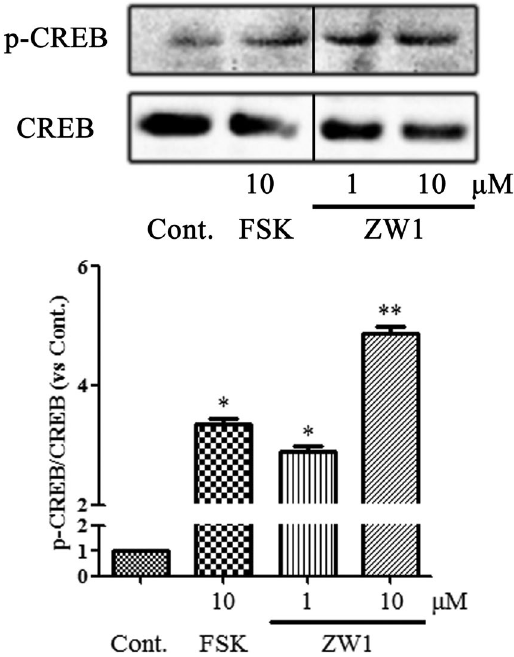
Figure 6. ZW1 promotes phosphorylation of CREB in KGN cells. KGN cells were treated with the test compounds at the indicated concentrations for 24 h. The cell lysates were immunoblotted with an anti-p- CREB or anti-CREB antibody. The relative amount of p-CREB to CREB protein was determined from the chemiluminescence intensities. The data are presented as mean ± SD. Cont., DMSO-treated control; FSK, 10 μ M forskolin. * p < 0.05, ** p < 0.01 compared with the control ( n = 3). Black line represents one band removed, which was treated by letrozole. The full western blot and the corresponding positions of the molecular weight protein markers are presented in Supplementary Fig.